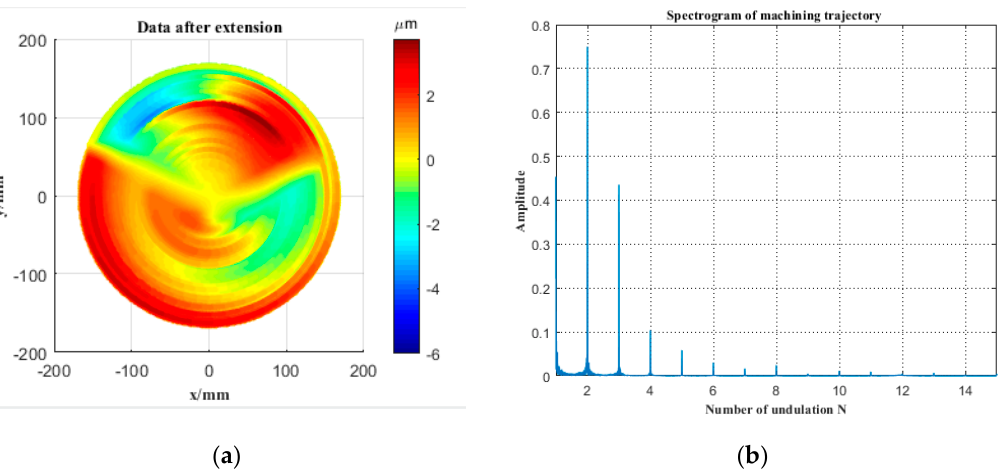
Figure 13. ( a ) Data after extension and ( b ) a spectrogram of the machining trajectory.